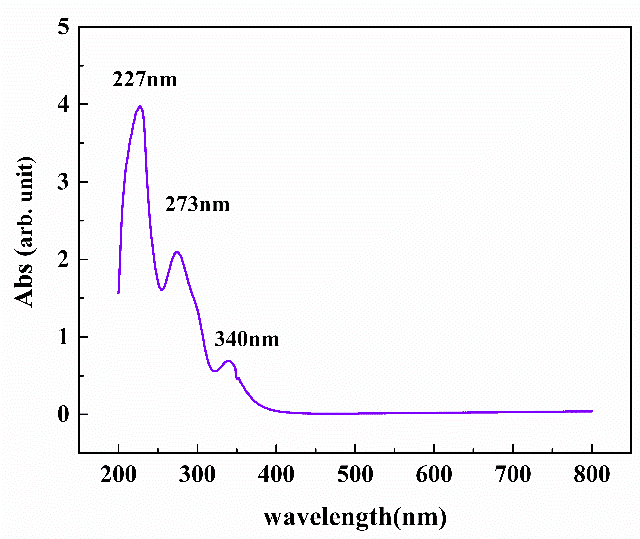
Figure 5. ( a ) Crystal precipitated after reaction; ( b ) composition of crystal. The UV-Vis results are shown in Figure 6 and the sample shows absorption peaks at 227 nm, 273 nm, and 340 nm after the gold is dissolved. The absorption peak of Au 0 is above 500 nm [28], so the Au in the sample after dissolution does not exist as a dispersed zero- valent gold colloid, but a high-valent gold ion. The absorption peak of Au(I) complexes is usually in the range of 200 nm–470 nm [29]. The sample absorption peaks at 227 nm and 273 nm are similar to (n-BuNC)AuICN [30]. Therefore, it can be inferred that the dissolved gold exists in the form of monovalent gold. In addition, the absorption peak at 340 nm belongs to the remaining CHI 3 .